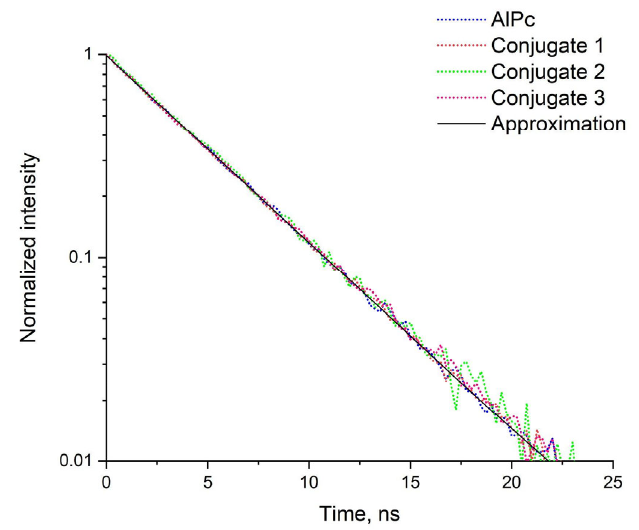
Figure 8. Luminescence decay curves of the conjugates and free AlPc. The molar concentration of QDs in three conjugates was 33 µ M. The molar concentration of AlPc in conjugate 1 and 3 was 20.4 µ M, in conjugate 2 was 10.2 µ M. The signal was recorded in the spectral range from 600 to 800 nm. The luminescence spectra of conjugates with PS molar concentrations of 20.4 μ M for conjugates 1 and 3, 10.2 μ M for conjugate 2, and free PS with a molar concentration of 29.5 μ M) upon excitation at 600 nm, have been compared. Here, the luminescence intensity is